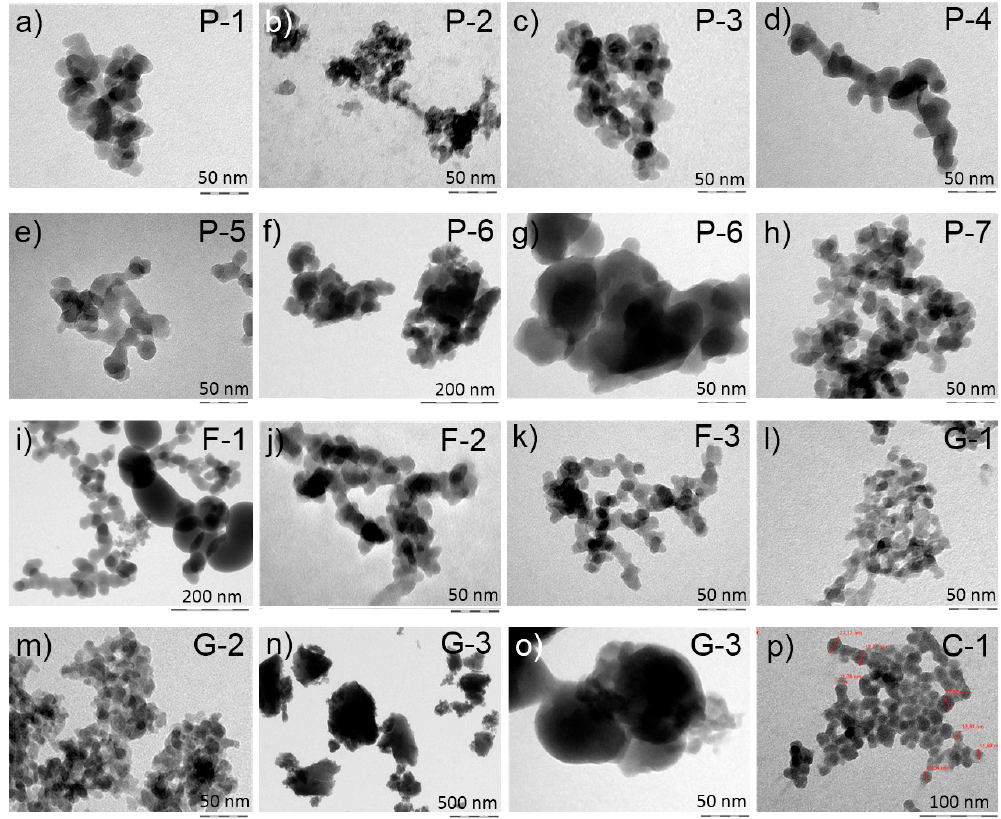
Figure 1. Electron microscopic images of the synthetic amorphous silica (SAS) used in the study. Typical aggregates are shown for precipitated ( a – h ), fumed ( i – k ), gel ( l – o ) and colloidal SAS ( p ). Abbreviations in the upper right corners refer to Table 1.